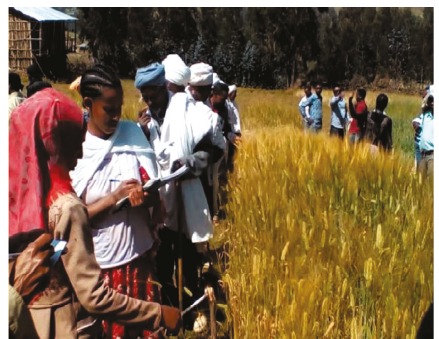
Figure 5: Field performance of malt barley varieties at Lay Gayint in 2020 cropping season.